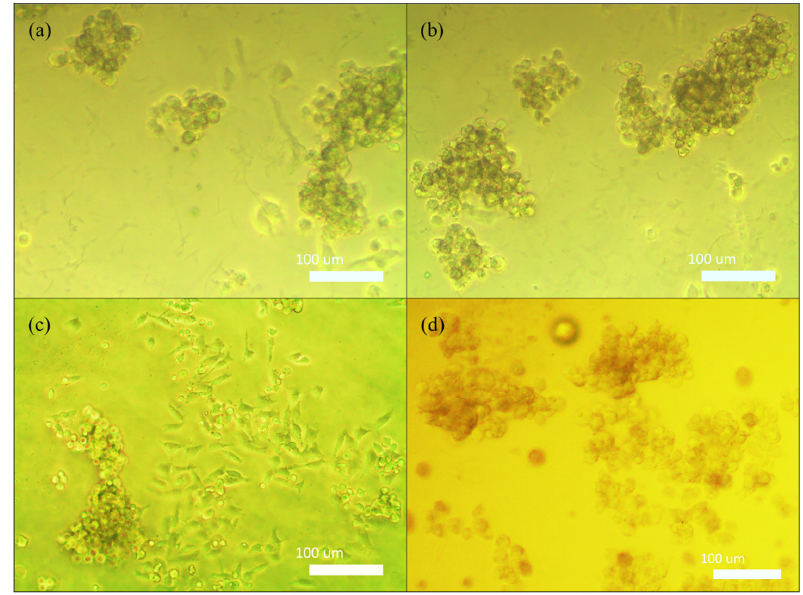
Figure 12. Phase-contrast microscopic images of HeLa cells cultured on the surface of ( a ) AGLC01, ( b ) AGLC05, ( c ) AGLC10, and ( d ) AGLC20 and after 24 h of incubation. Image scale is 100 micrometer (um).